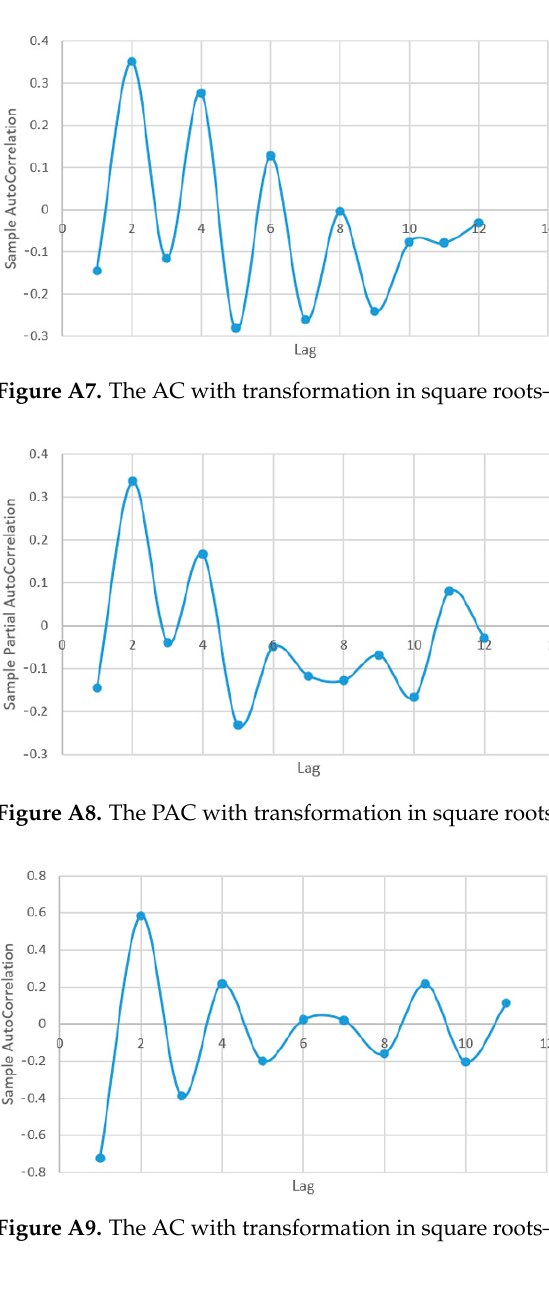
Figure A10. The PAC with transformation in square roots—BH series.